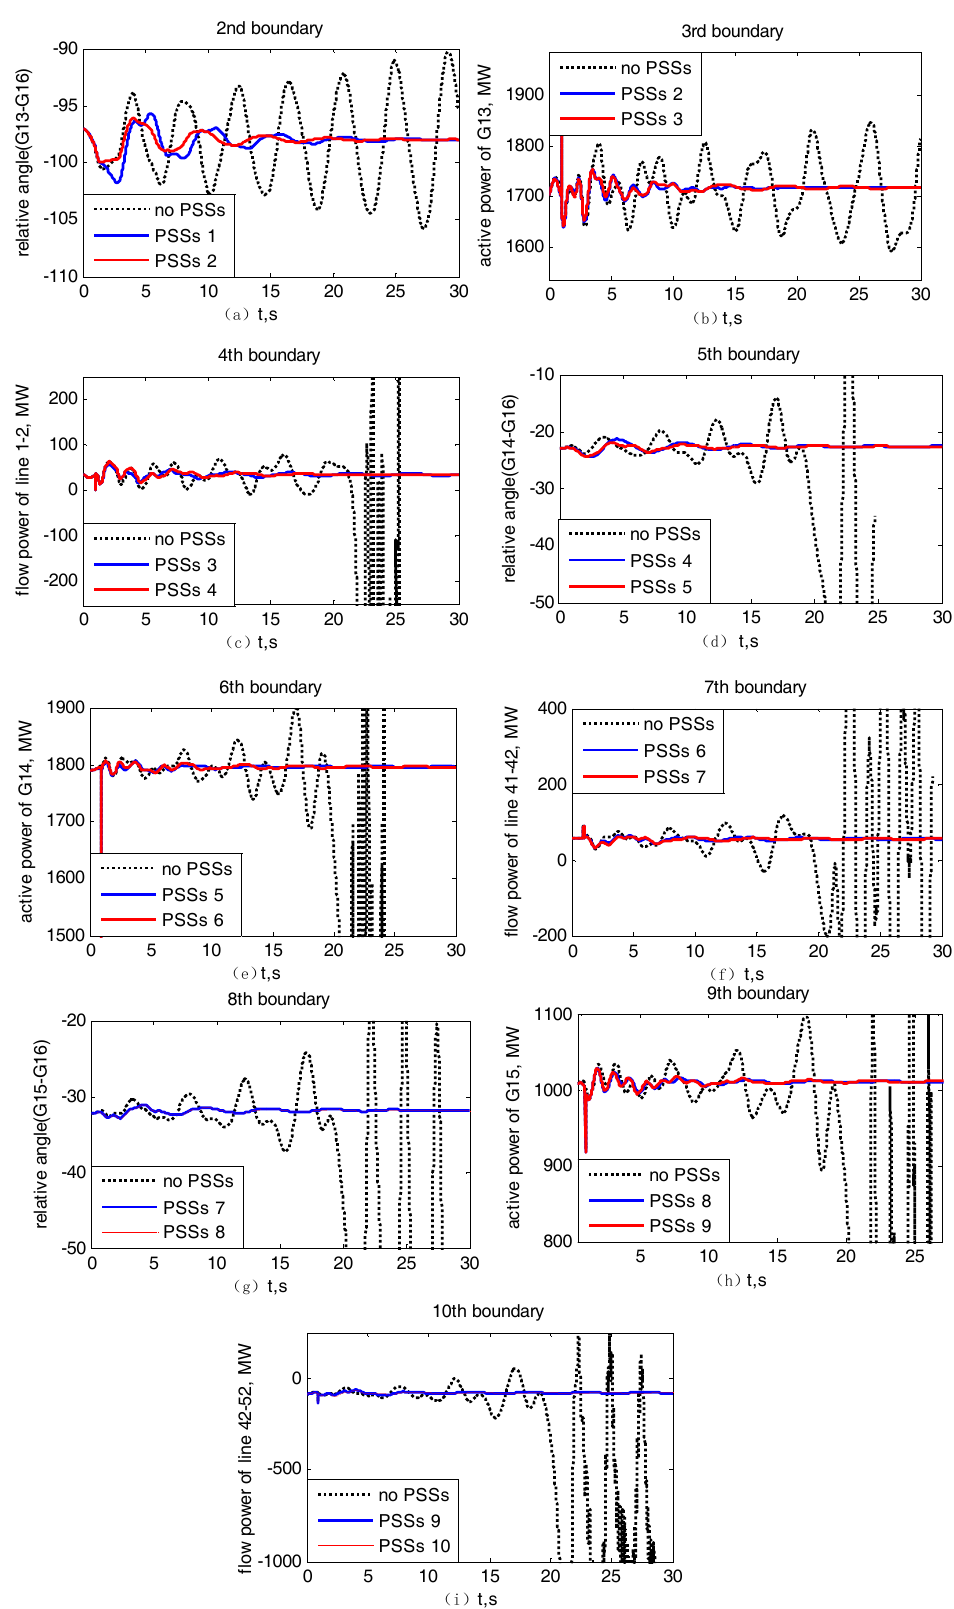
Figure 8. Dynamic responses with different controllers in the case of subspaces boundaries.